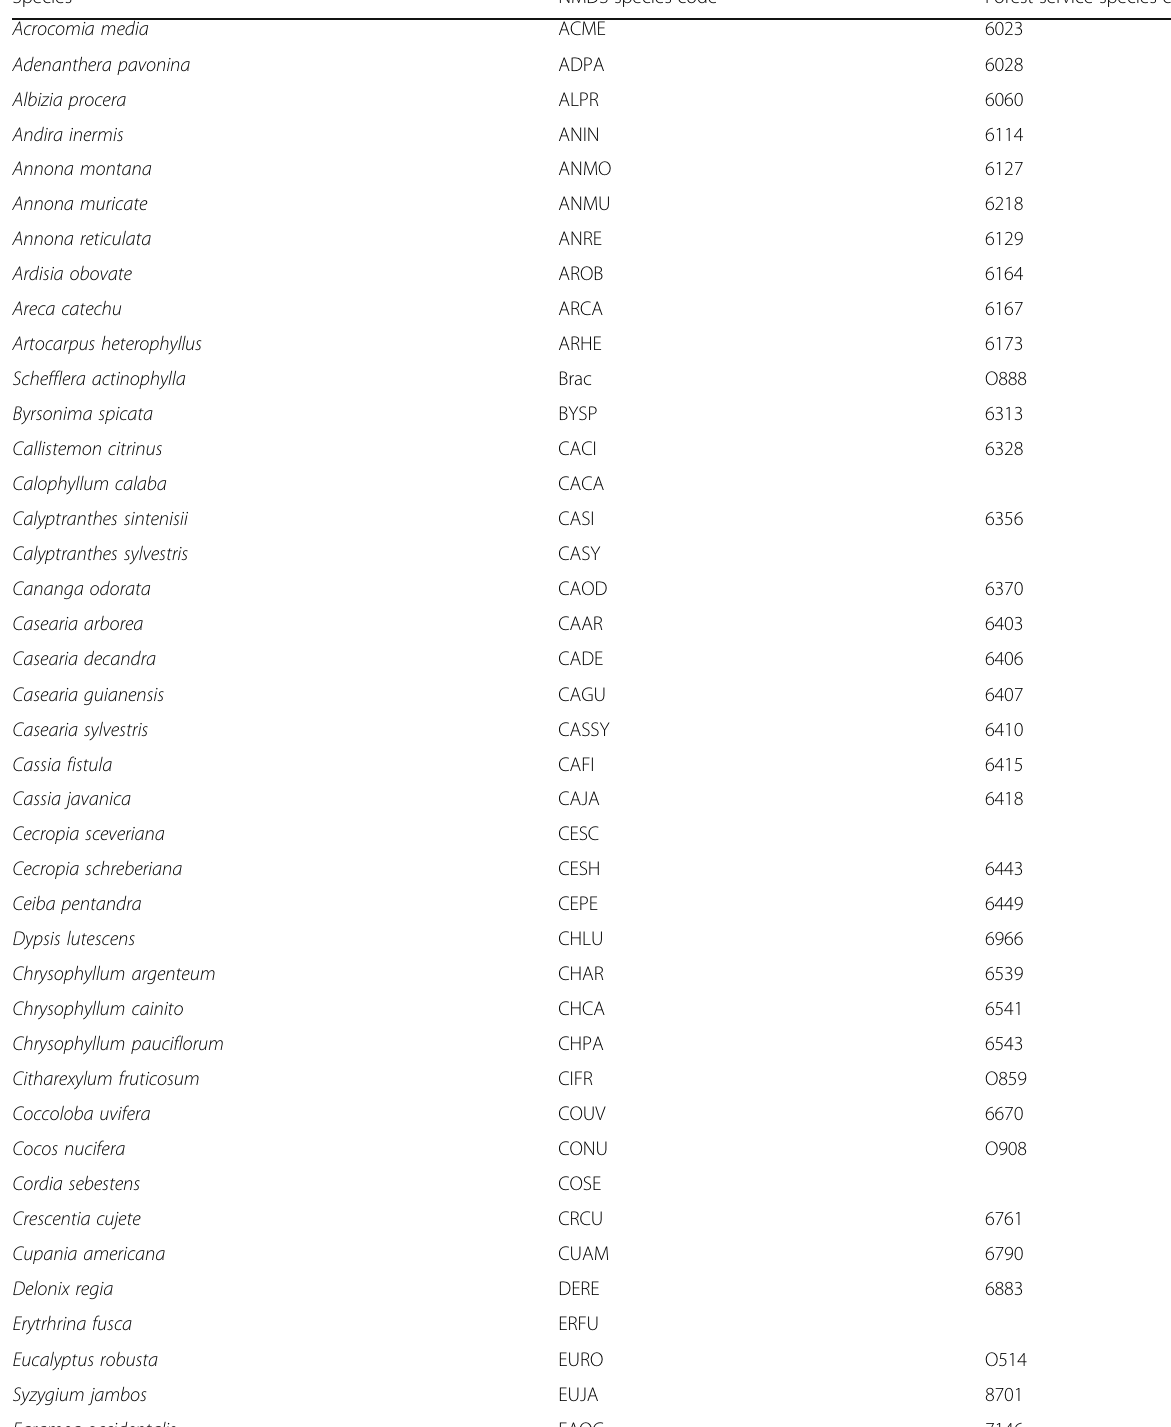
Table 7 Species found in JB-BN with species codes used in the Appendix 1 NMDS ordinations and found in Appendix G of the For- est Inventory and Analysis (FIA) user guide